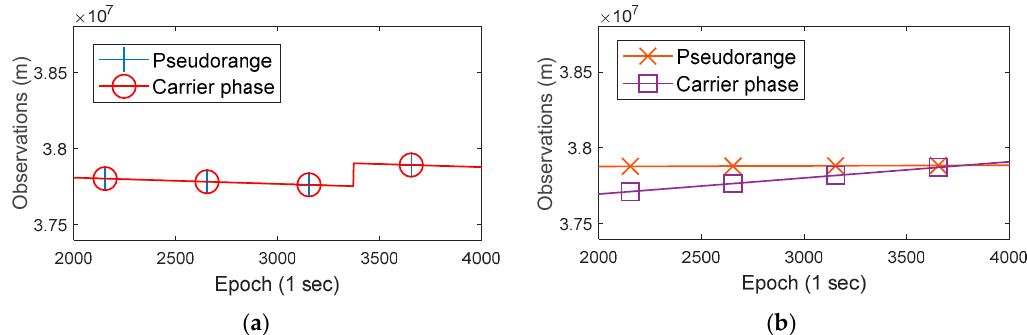
Figure 3. The pseudorange and carrier phase observations (BDS 02 satellite) of a geodetic receiver and a Huawei P10 smartphone. ( a ) The observations of a geodetic receiver; ( b ) The observations of a Huawei P10 smartphone. The actual acquired carrier phase of smartphones is a set of data that is cumulatively incremented from 0 m at the beginning of observation, thus the values are small. In this figure, the mobile phone carrier phase values are added a constant.